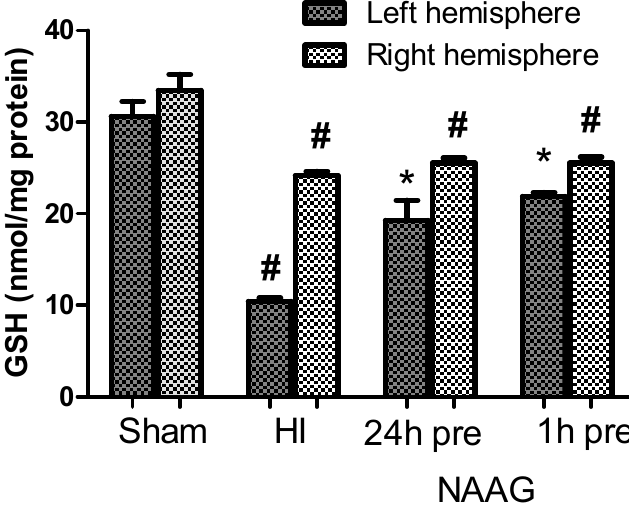
Figure 6. Effect of NAAG application on changes in the GSH concentration in the brains of rat pups after HI. The results are presented as the means ± SEM, n = 5–6; statistically significant differences: * p < 0.005 compared to the H ‐ I group, # p < 0.001 compared to the sham operated group.